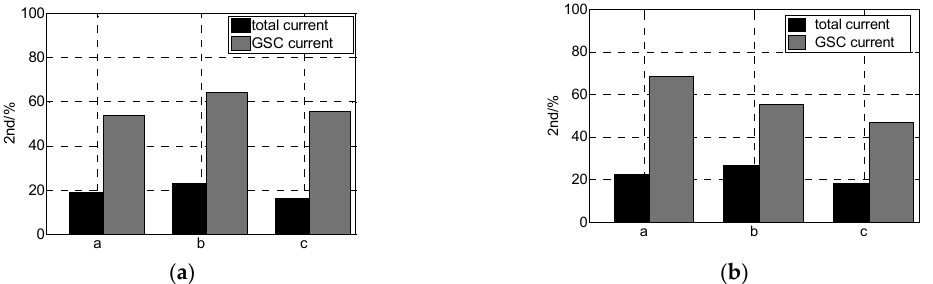
Figure 8. Proportions of the second harmonic component in short-circuit current of DFIG-WT and GSC: ( a ) supersynchronous, s = − 0.2; ( b ) subsynchronous, s = 0.2.